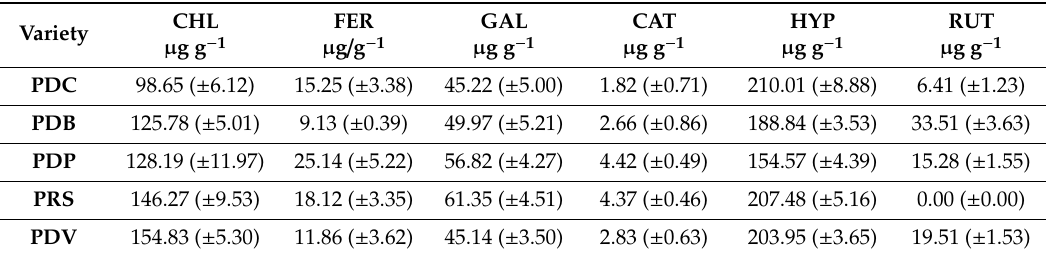
Table 3. Polyphenol composition of the five landraces of tomato “Piennolo”. The data are shown as average of three independent experiments ( ± SD). Legend: PDC = “Piennolo Centoscocche”; PDB = “Piennolo Principe Borghese”; PDP = “Piennolo di Pollena”; PRS = “Piennolo Rosso Vesuviano”; PDV = “Piennolo Vesuviano”; CHL = chlorogenic acid; FER = ferulic acid; GAL = gallic acid; CAT = catechin; HYP = hyperoside; RUT = rutin.